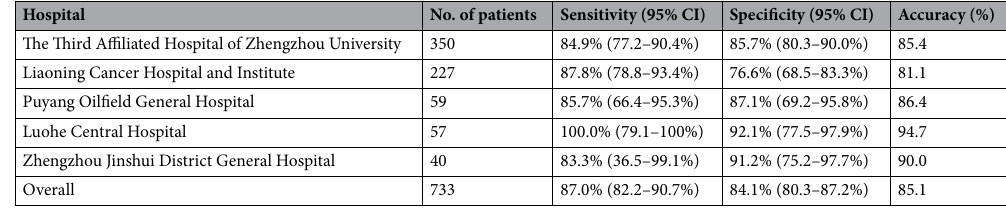
Table 3. OCT diagnosis